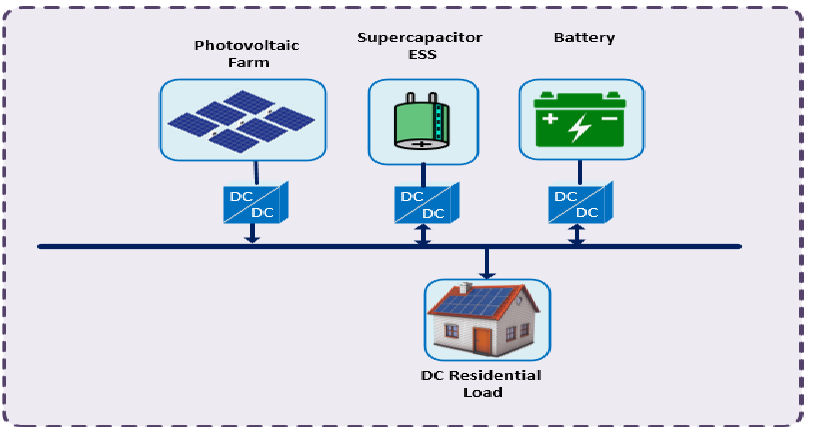
Figure 2. DC MG configuration .